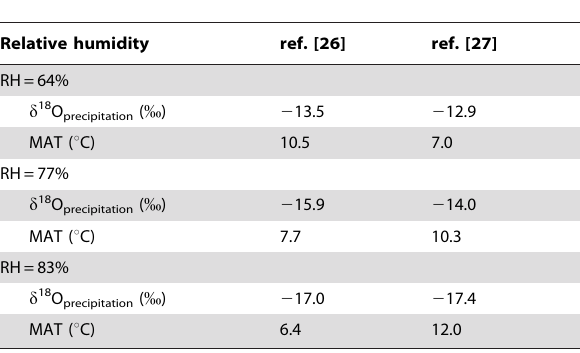
Table 2. Two estimates of Early Eocene d 18 O precipitation [35,36] and corresponding mean annual temperature (MAT) [37] derived from Panda cellulose for minimum, mean, and maximum inferred values of relative humidity